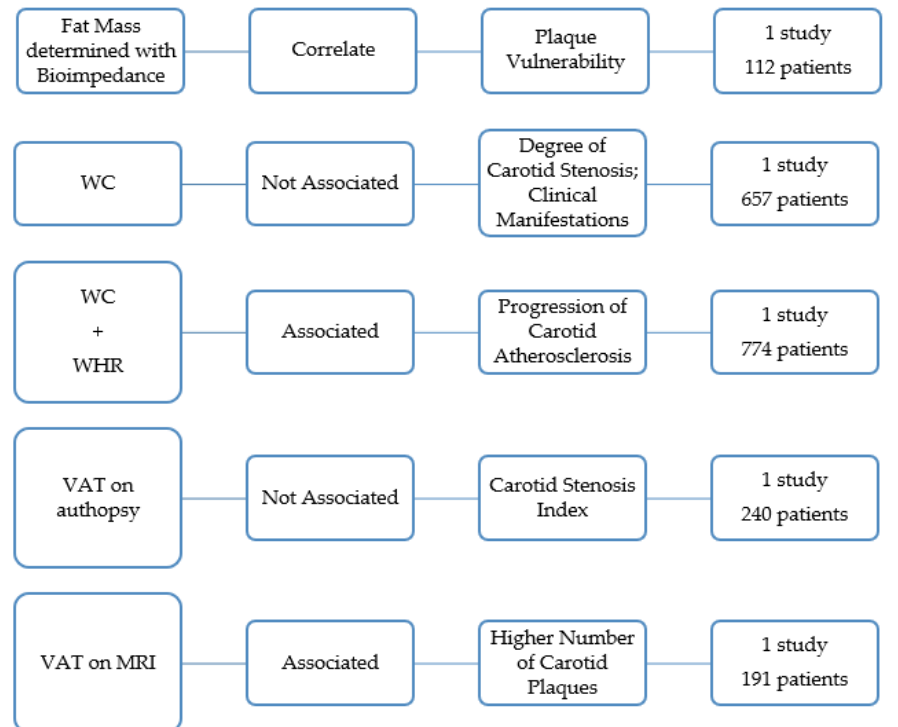
Figure 5. Overview of the studies that analyze the association between visceral obesity and the characteristics of the carotid atherosclerotic plaques.